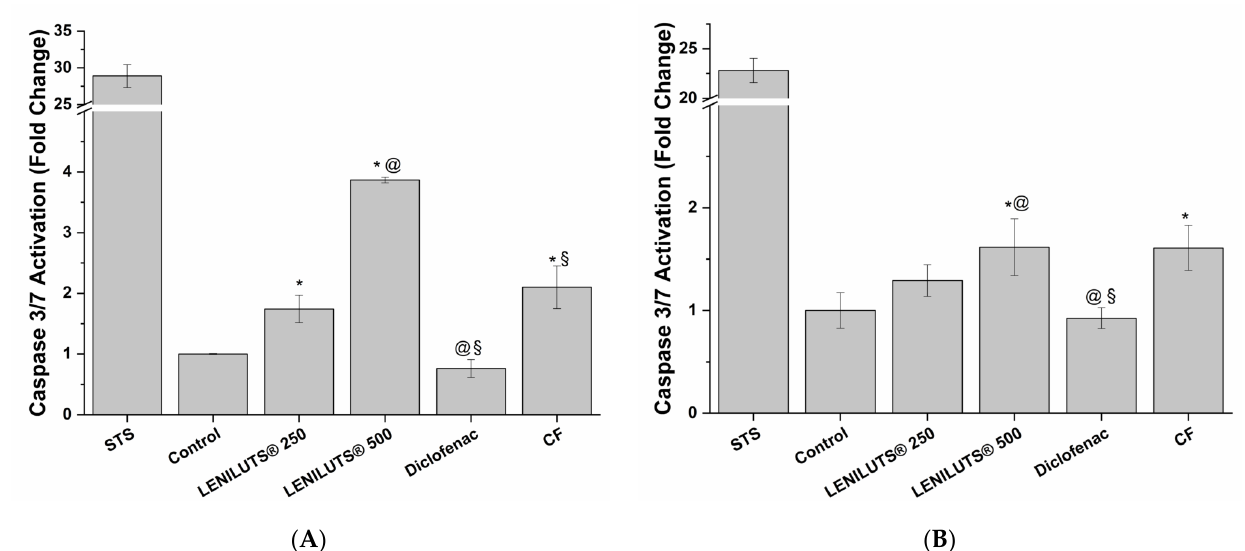
Figure 3. Caspase 3/7 activation compared to non-inflamed, untreated LNCaP cells ( A , Ctrl) and inflamed, untreated LNCaP cells ( B , Ctrl) following 6 h treatment with LENILUTS ® , CF, Finasteride and staurosporine (STS, positive control). * p < 0.05 vs. control, @ p < 0.05 vs. LENILUTS 250, § p < 0.05 vs. LENILUTS 500.